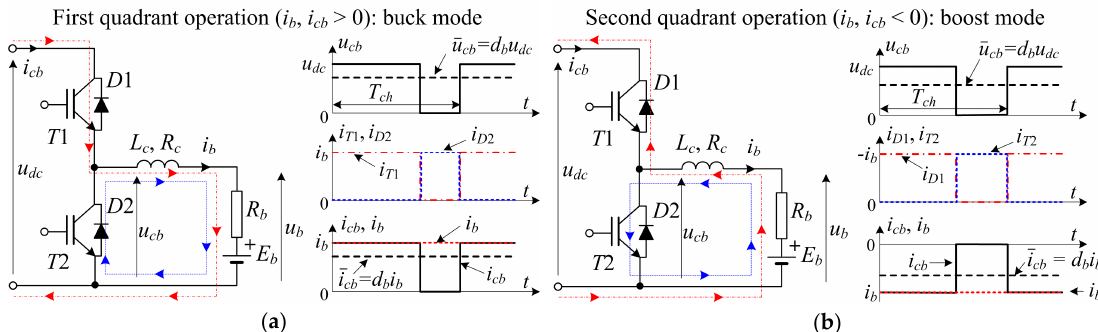
Figure 3. Illustration of voltage and current relationships at semiconductor switches T 1 and T 2 and fly-wheeling diodes D 1 and D 2, and input/output current and voltage relationships of two-quadrant DC/DC power converter for buck operation ( a ) and boost operation ( b ).